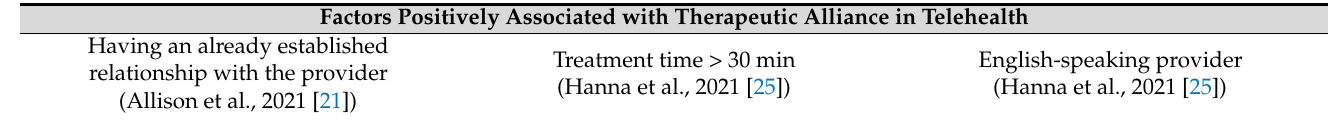
Table 2. Factors positively associated with therapeutic alliance in telehealth visits. Factors Positively Associated with Therapeutic Alliance in Telehealth Having an already